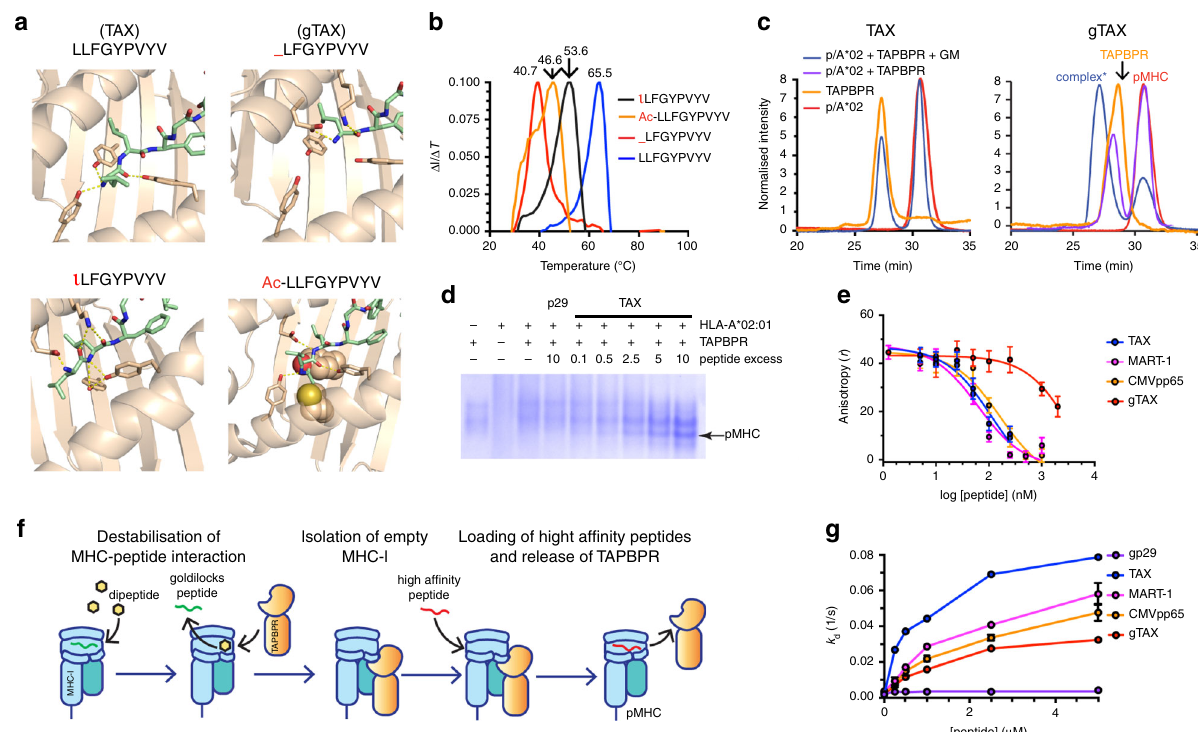
Fig. 3 Capturing empty HLA-A*02:01/TAPBPR complexes for peptide exchange. a Structure-based design of goldilocks peptides: comparison of polar contacts between HLA-A*02:01 and the N-terminal region of LLFGYPVYV (TAX) peptide (upper left). _LFGYPVPYV (gTAX) (upper right), Ac- LLFGYPVYV (bottom right) and lLFGYPVYV where l = D-Leucine (bottom left). Structures were modeled using PDB ID IDUZ 26 . b Peptide complex thermal stabilities of HLA-A*02:01 bound to TAX, lLFGYPVYV, Ac-LLFGYPVYV and gTAX. c SEC TAPBPR binding assays of TAX/HLA-A02:01 (left), gTAX/HLA- A02:01 (right). d Native gel electrophoresis of HLA-A*02:01/TAPBPR complex incubated with a 10-fold molar excess of a non-speci fi c peptide (p29, YPNVNIHNF) or varying molar excess of a speci fi c, high-af fi nity peptide (TAX). 12% polyacrylamide native gels were run at 90 V for 5 h at 4 °C before visualization with InstantBlue (Expedeon). Data shown are representative of triplicate gel assays. e Competitive binding of TAMRA-TAX to puri fi ed HLA- A*02:01/TAPBPR complexes from ( c ) as a function of increasing peptide concentration, measured by fl uorescence polarization. f Conceptual diagram of TAPBPR-mediated capture and peptide loading on empty MHC-I molecules. g Bio-Layer Interferometry analysis of TAPBPR dissociation from HLA-A*02:01